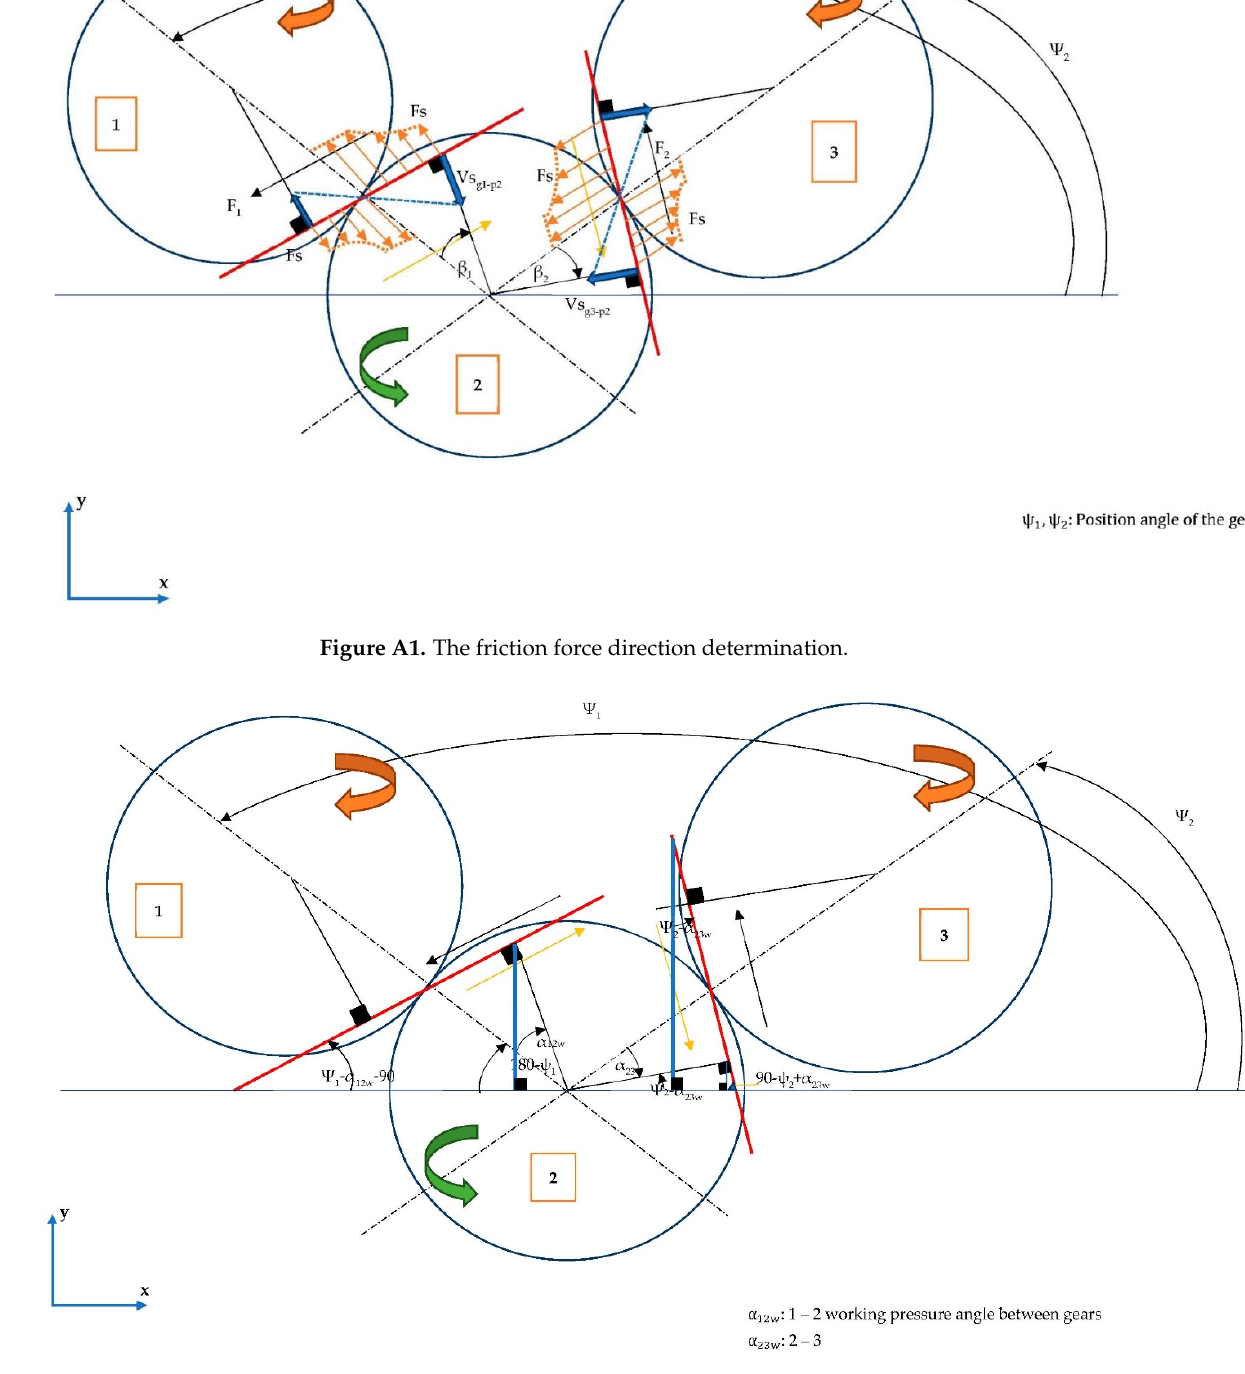
Figure A2. Determining the angles to the line of action direction in the torque split model.